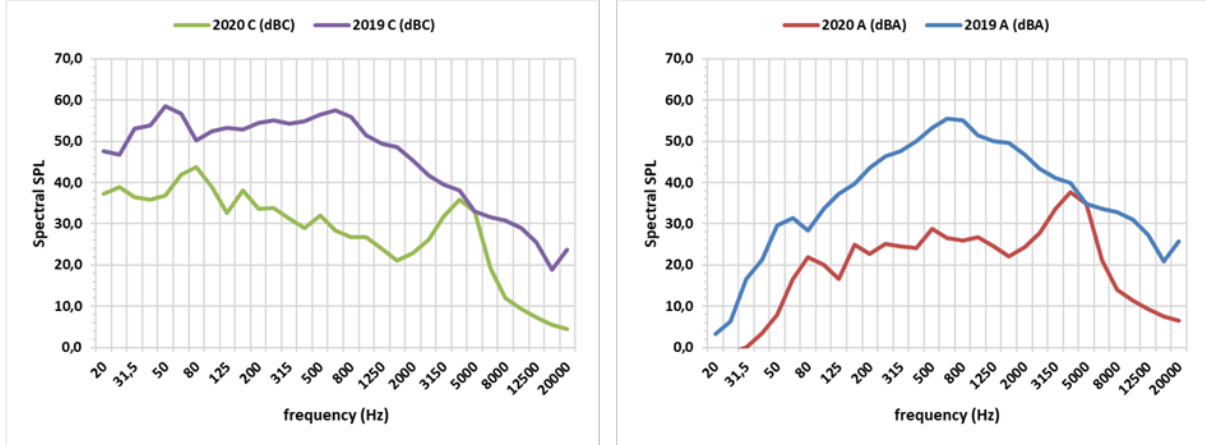
Figure 9: Overall C and A-weighted sound spectrum in 2019 vs 2020 at site no. 4